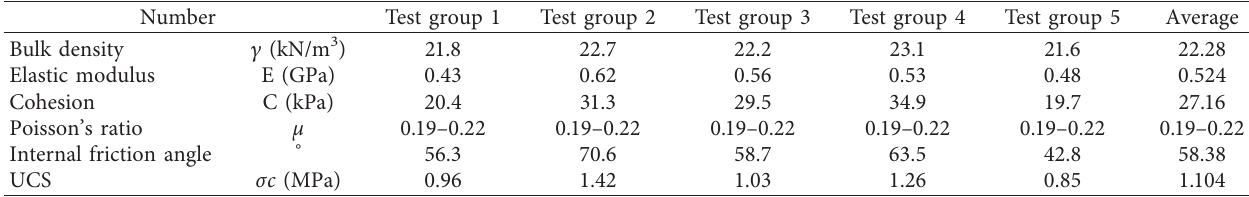
Table 2: Mechanical indices of similarity materials prepared from sand, gypsum, lime, and barite